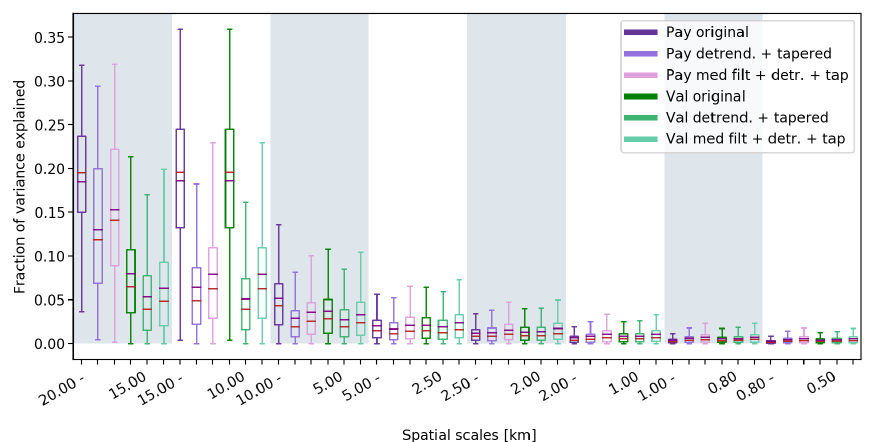
Figure 7. Box plots illustrating the effects of median filtering, detrending and tapering on the original melting layer tops for Payerne data (purple) and Valais data (green).